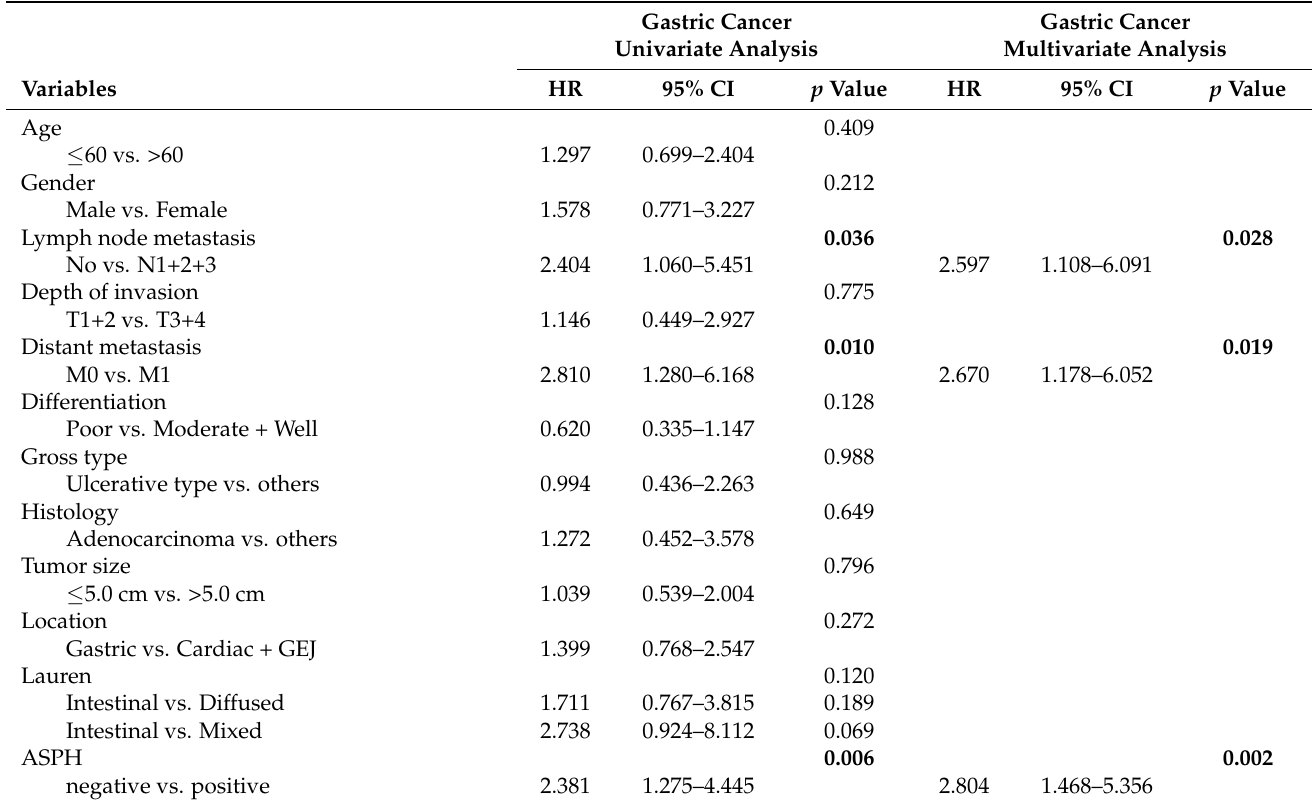
Table 1. Univariate and multivariate analysis for 5-year overall survival of 70 GC patients after neoadjuvant chemotherapy. Gastric Cancer Gastric Cancer Univariate Analysis Multivariate